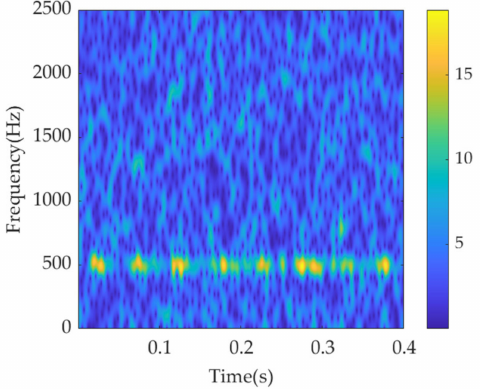
Figure 2. STFT spectrum of the simulation